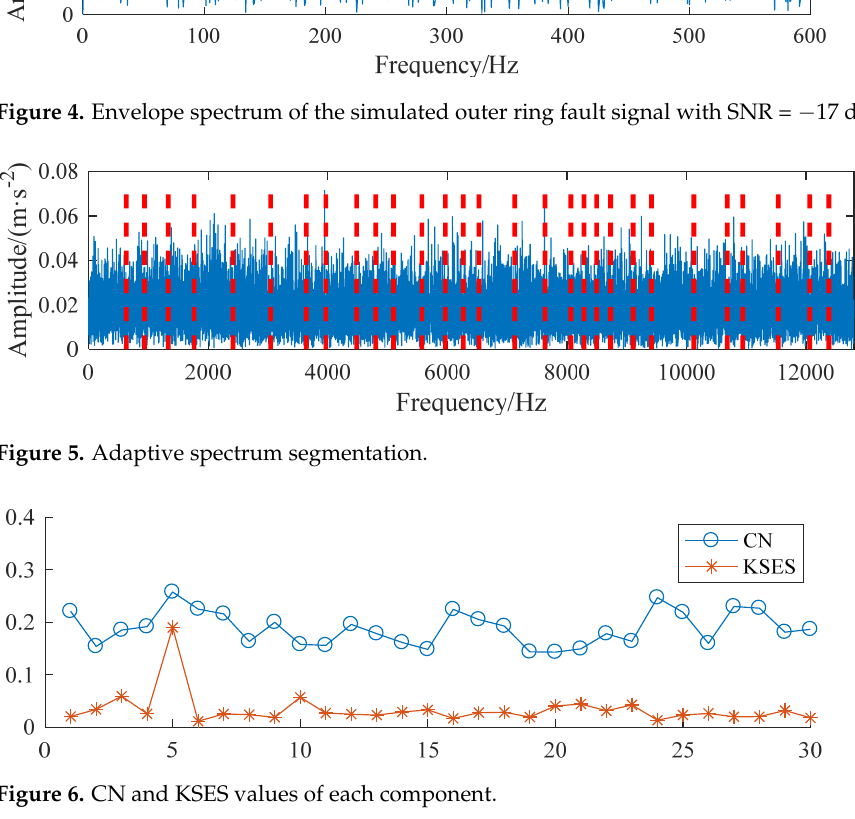
9 of 19 Figure 2. Flowchart of Algorithm for Feature Extraction of Weak Faults of Rolling Bearings. 5. Simulation and Experimental Verification 5.1. Simulation Verification The simulation signal y ( t ) is constructed according to the characteristics of the inter ‐ nal ring of the rolling element and the outer ring of the rolling bearings when the peeling failure occurs. Its expression is [23,24]: y( )